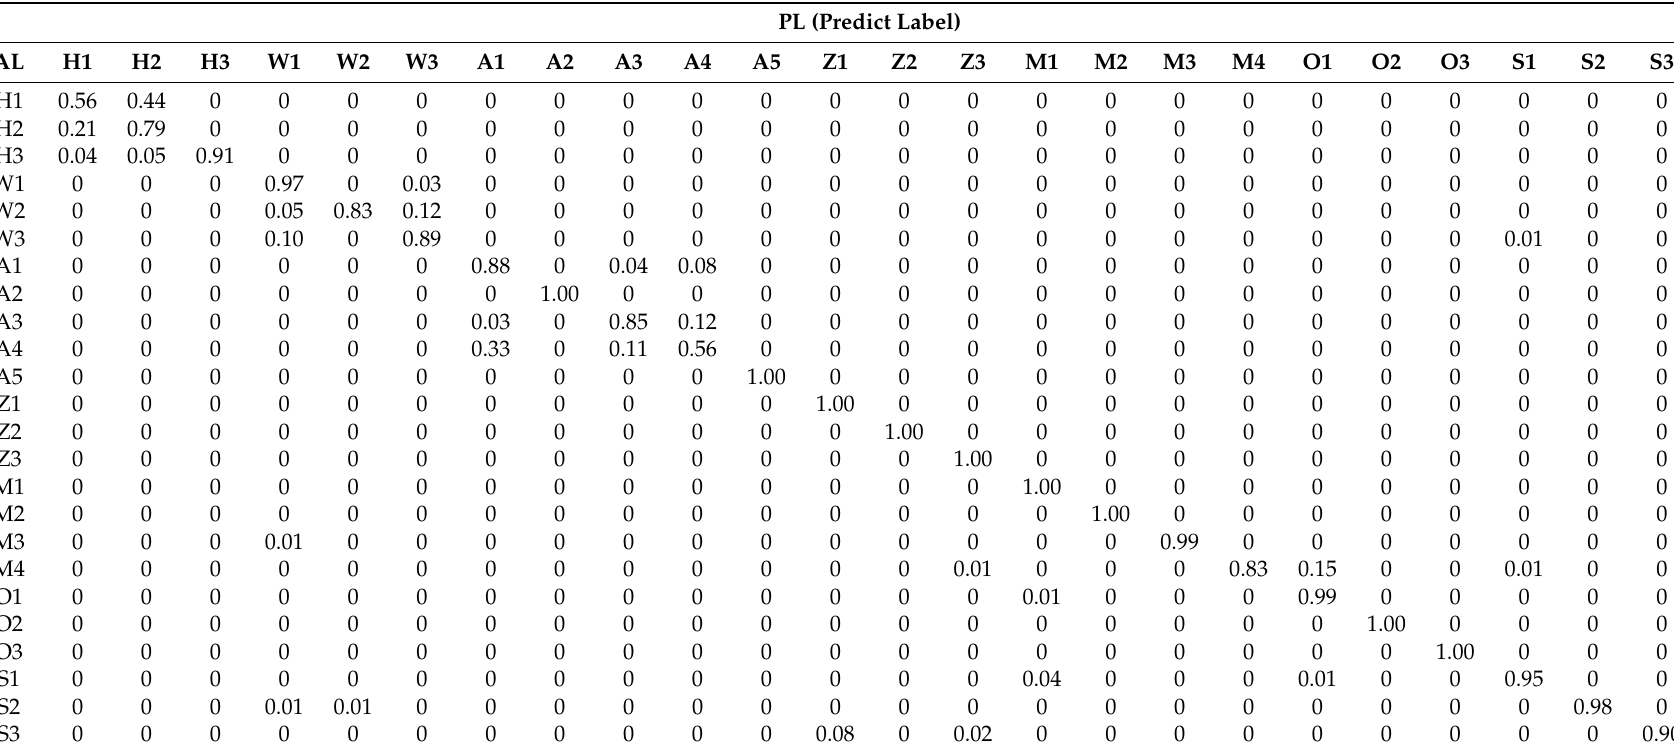
Table 2. Specific classification results of MFCC for the clean test set